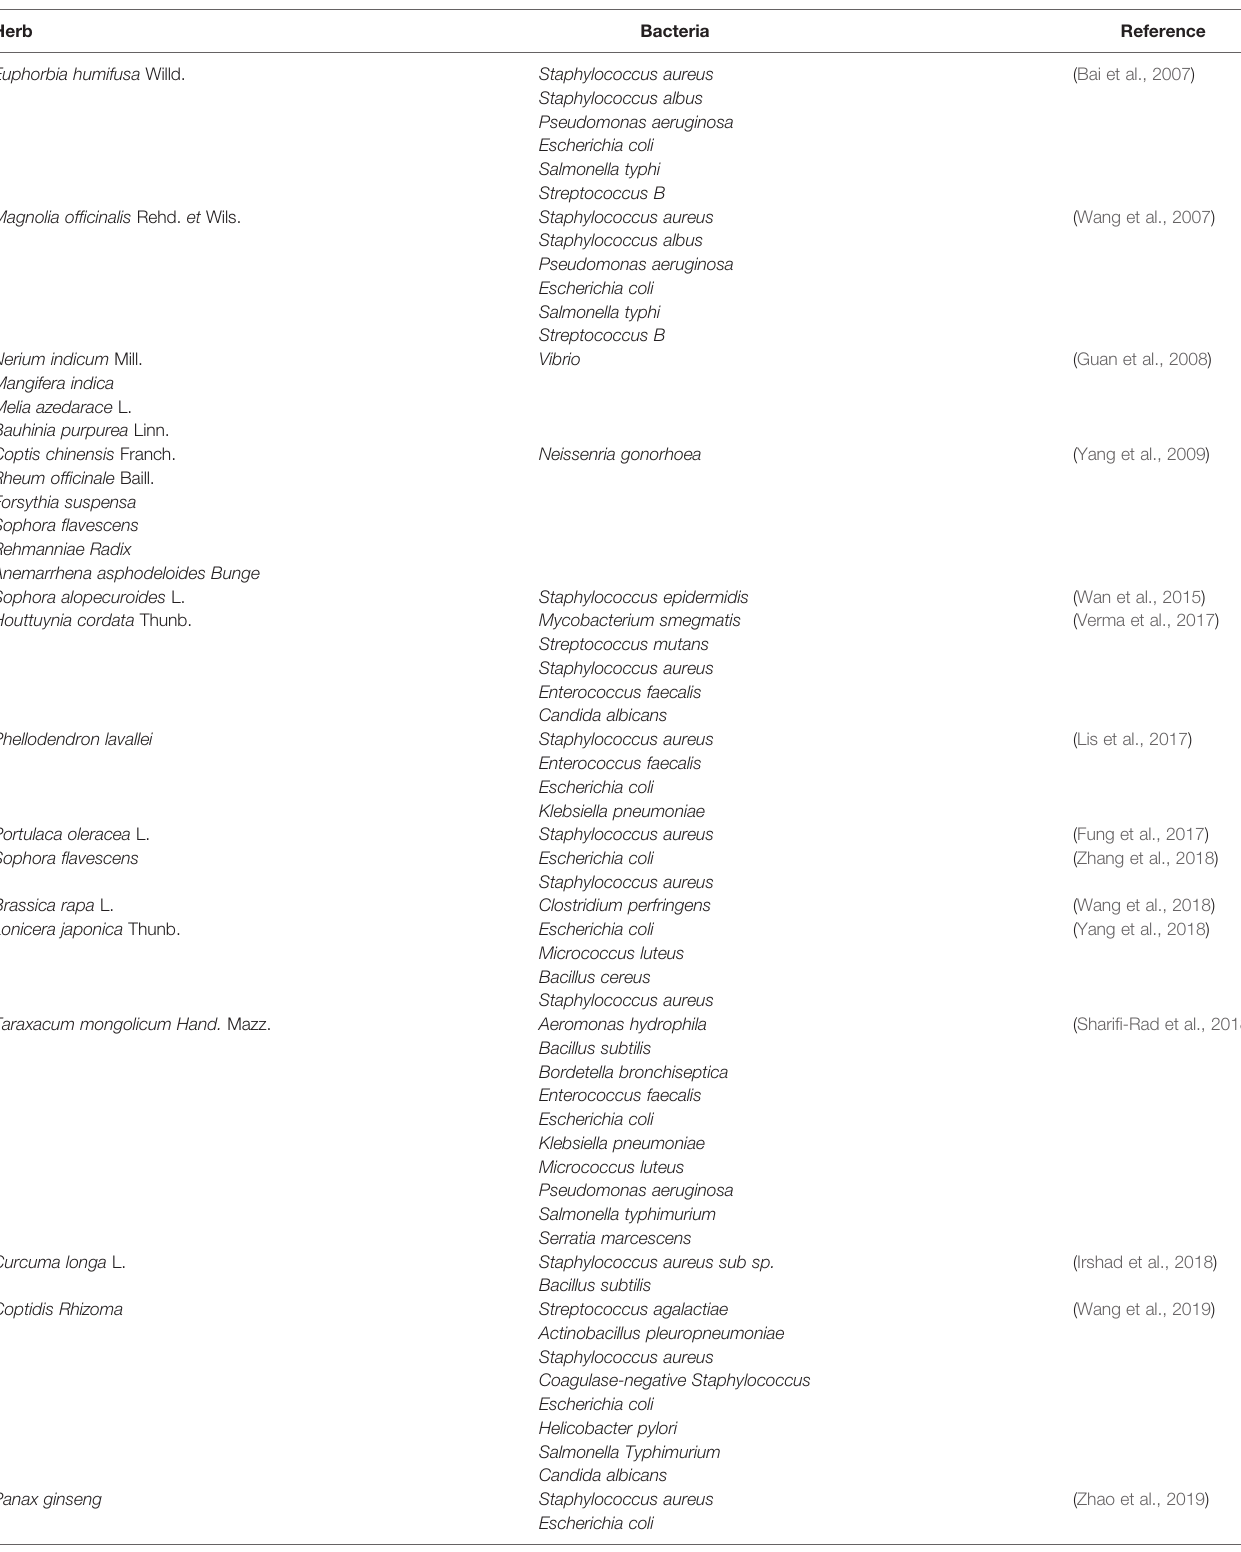
TABLE 1 | Antibacterial effects of traditional Chinese medicine